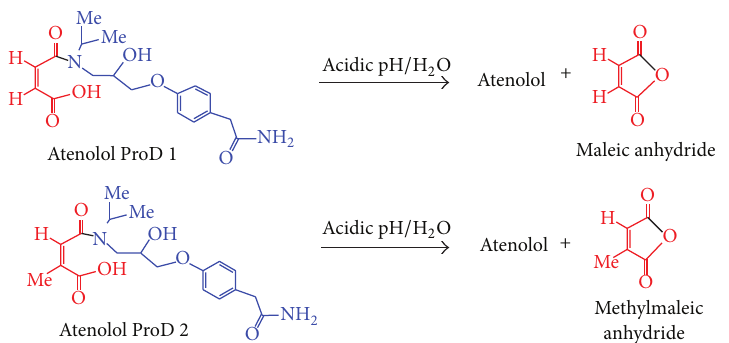
Figure 3: Acid-catalyzed hydrolysis for atenolol ProD 1-ProD 2.